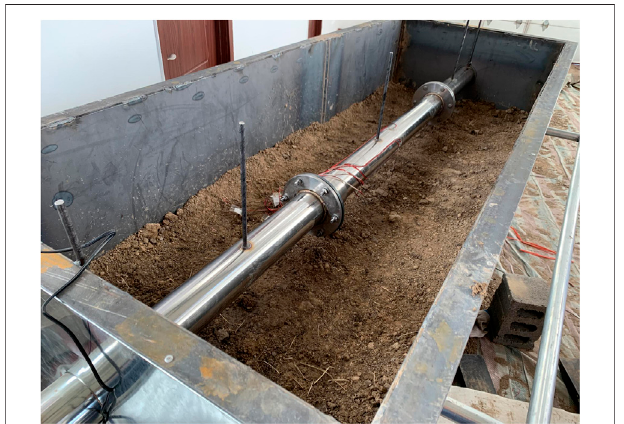
FIGURE 2 | The test box layout.